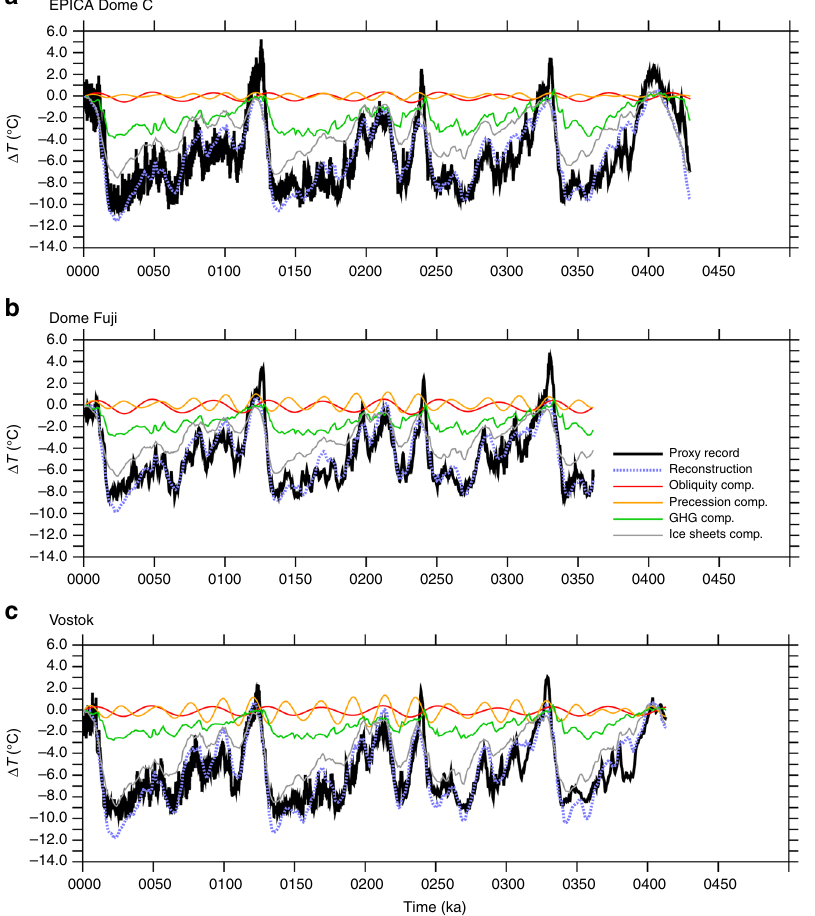
Fig. 5 Temperature signals in ice cores and seasonally-averaged linear reconstructions. Like Fig. 2, but using the best fi t seasonal weighting for the GFDL CM2.1 linear reconstruction (black dots in upper row of Fig. 4). Temperatures over the past several glacial cycles from ice cores (black) and GFDL CM2.1 seasonally-averaged model-based linear reconstructions (dashed blue) for a EPICA Dome C, b Dome Fuji, and c Vostok. The model-based linear reconstructions are the sum of seasonally weighted contributions from obliquity (red), precession (orange), greenhouse gases (green), and ice sheets (gray). The weighting is a July – September for EPICA Dome C, b July – November for Dome Fuji, and c October for Vostok, although other seasonal means also improve the fi t compared to the annual mean case (Fig. 4). The seasonally weighted reconstructions shown here generally match the obliquity and precession-scale variability in the proxy records better than the annual mean reconstructions shown in Fig.